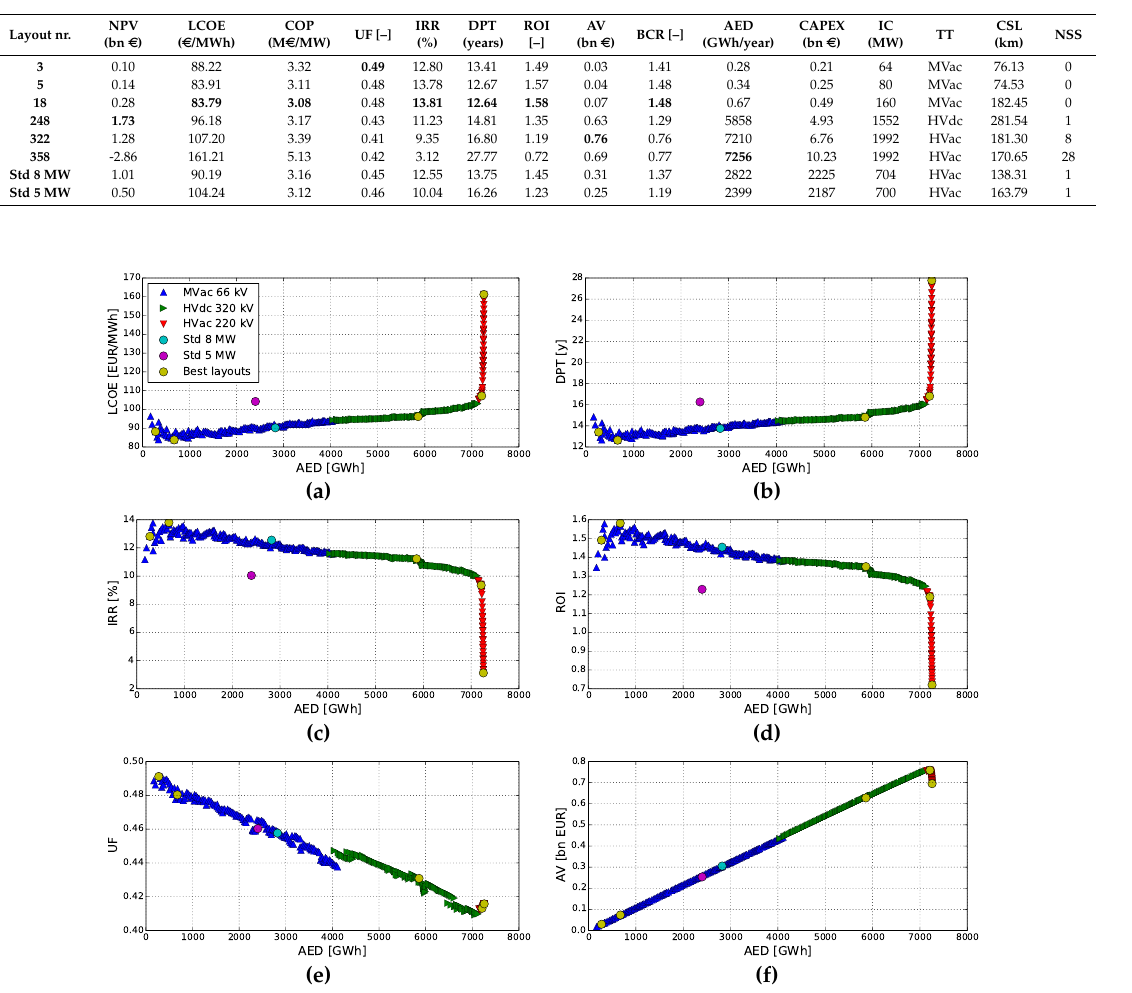
Table 8. Economic values and general characteristics of the best layouts.